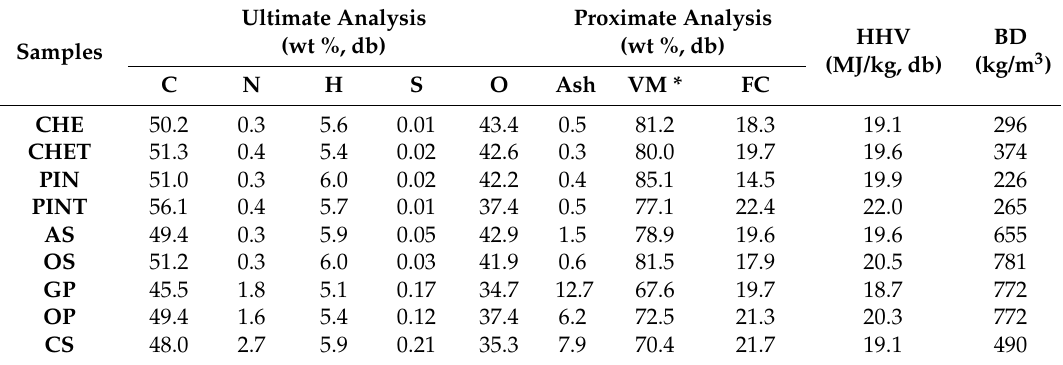
Table 1. Proximate and ultimate analyses, high heating value (HHV) and bulk density of the studied samples.